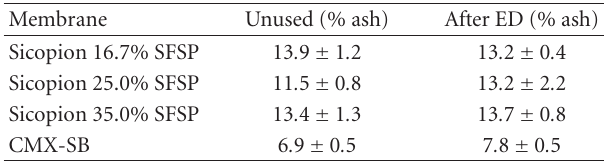
Table 3: Ash content (in dry basis %) of unused (after the stabi- lization procedure) and used (after the demineralization procedure)